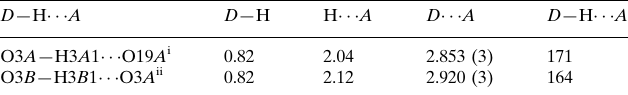
Hydrogen-bond geometry (A˚ , (cid:3)